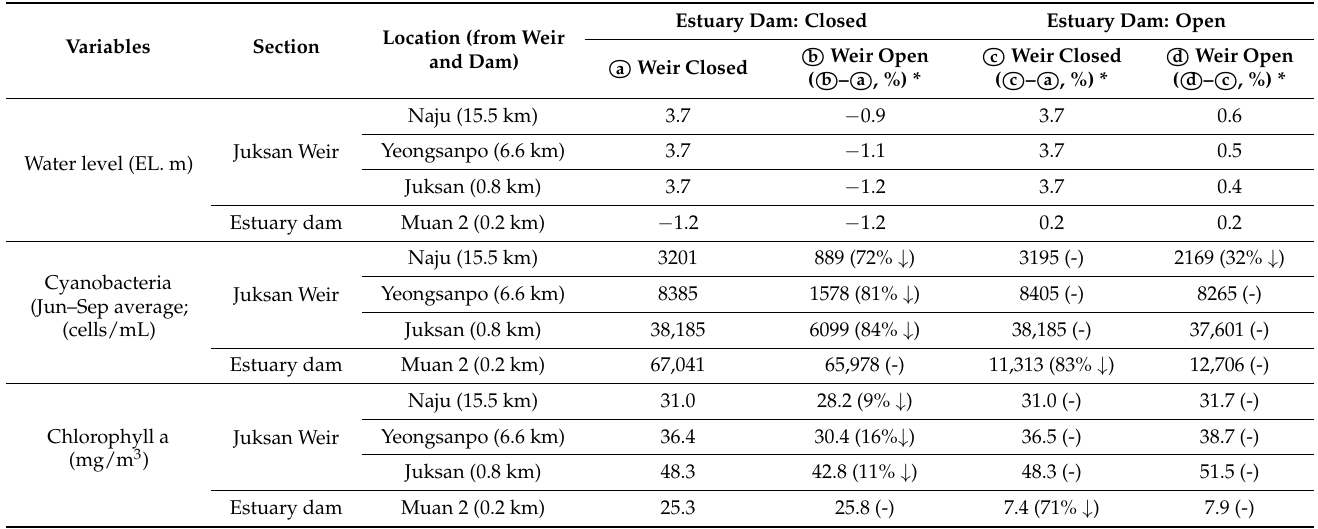
Table 8. Simulation results according to the operating conditions of the Juksan Weir and estuary dam.